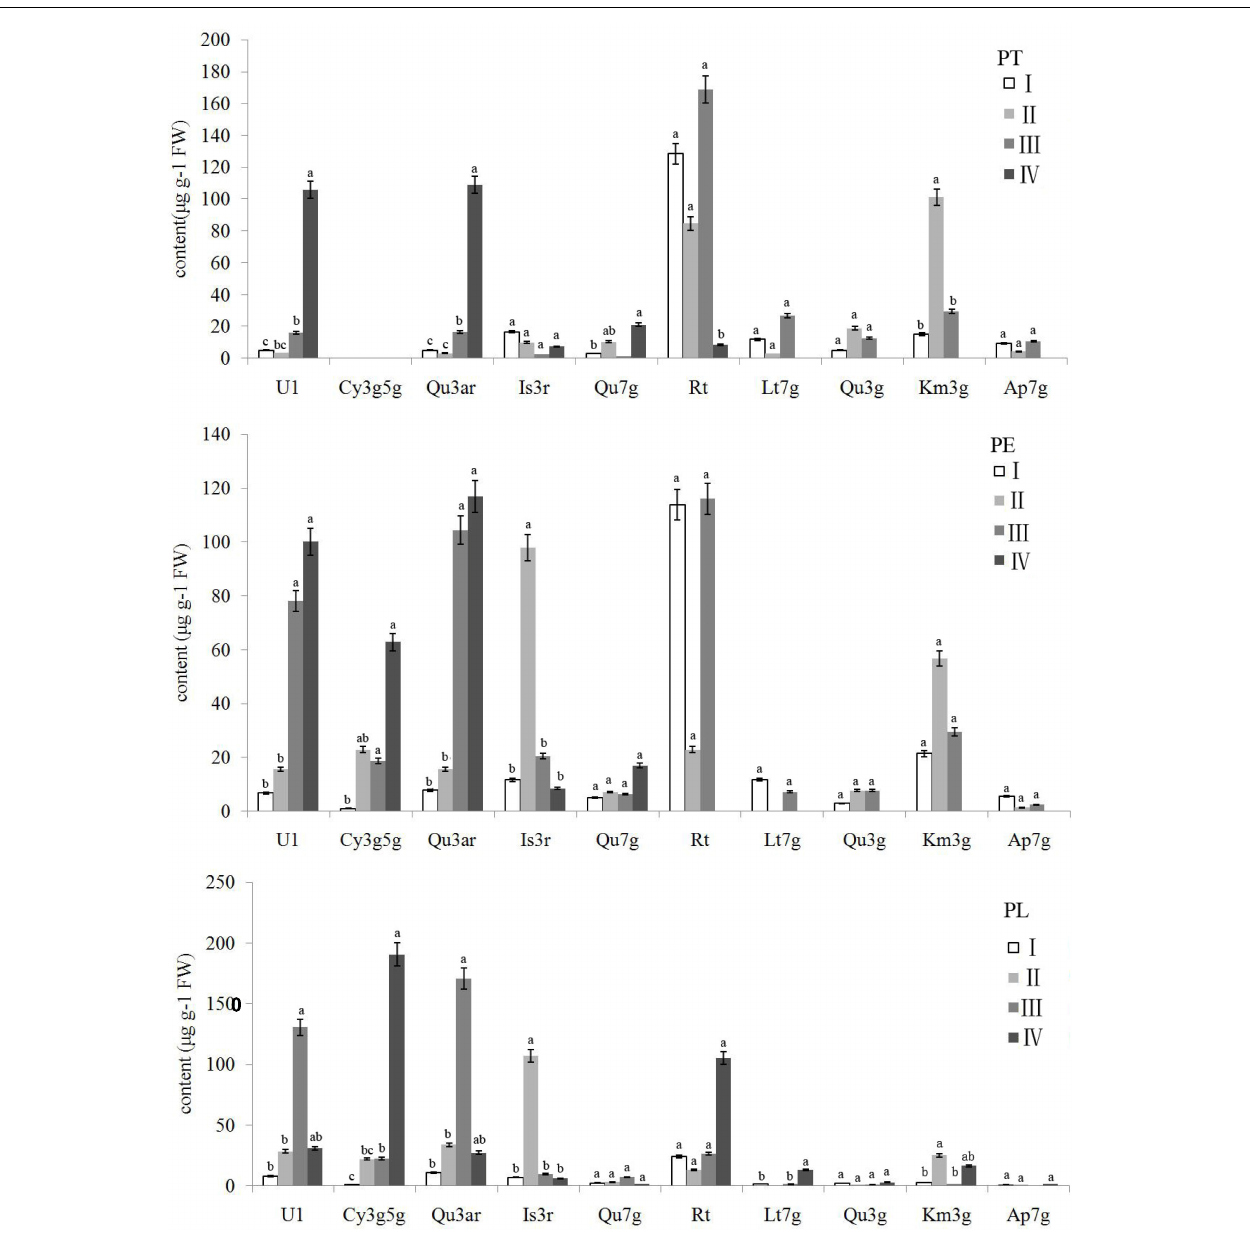
FIGURE 6 | Variations in ten major flavonoids between four clusters. Letters in common are significantly different ( p < 0.05). ST, sepal throat; SE, sepal eye; SL, sepal limb; PT, petal throat; PE, petal eye; PL, petal